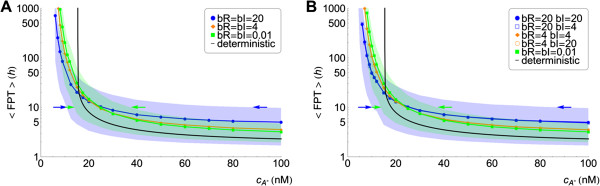
Mean first passage time of cell activation for different burst size values. Mean first passage time of cell activation as a function of autoinducer concentration for different values of the burst size for LuxR (bR) and LuxI (bI) and for the deterministic solution: (A) low to high transition MFPT in the lux01 operon, (B) low to high transition MFPT in the lux02 operon. The lower (upper) limit of the shaded regions is the 10% (90%) quantile curve of the distribution of FPT for the cases bR=bI=20 (blue shaded region) and bR=bI=0.01 (green shaded region). The MFPT reveals a non-trivial behaviour: for low autoinducer concentration noise helps cells to jump quicker to the high state, while for high autoinducer concentration noise slows down the cells activation (see text). Intersections of the quantile 10% and quantile 90% curves with a horizontal line at t=10h indicate the autoinducer concentration for which 10% of cell trajectories have jumped to the high state (left arrow) and the concentration for which 90% of cell trajectories have been activated (right arrow). The precision after 10h of induction (inversely proportional to the width of the region delimited by the arrows), increases when decreasing the noise in LuxR (see text). Note that in the case of the lux01 operon, we only change the value of bRsince GFP does not contribute to the activation process.